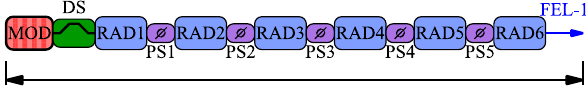
FIG. 1. Schematic layout of the FEL-1 undulator system. See text for details.